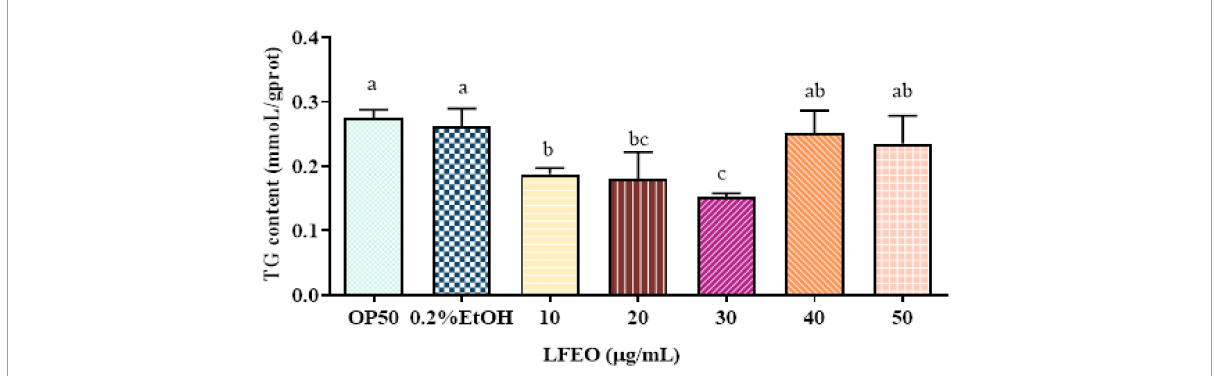
FIGURE2 The effect of litchi flower essential oil (LFEO) on triglycerides (TG) content in different concentrations. Worms were fed with LFEO at different concentrations and cultured at 20 ◦ C for 60 h ( n = three biologically independent samples; one-way analysis of variance (ANOVA) with Bonferroni tests as post hoc comparison; different letters indicate a significant difference, p <